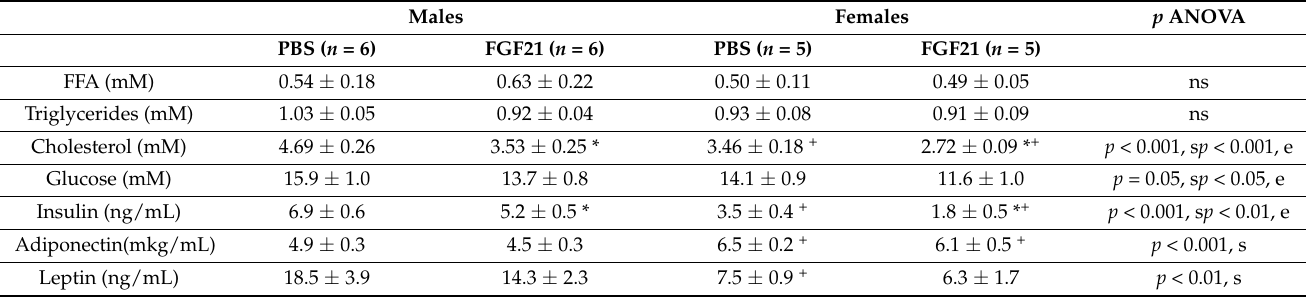
Table 2. Biochemical blood parameters in male and female mice.